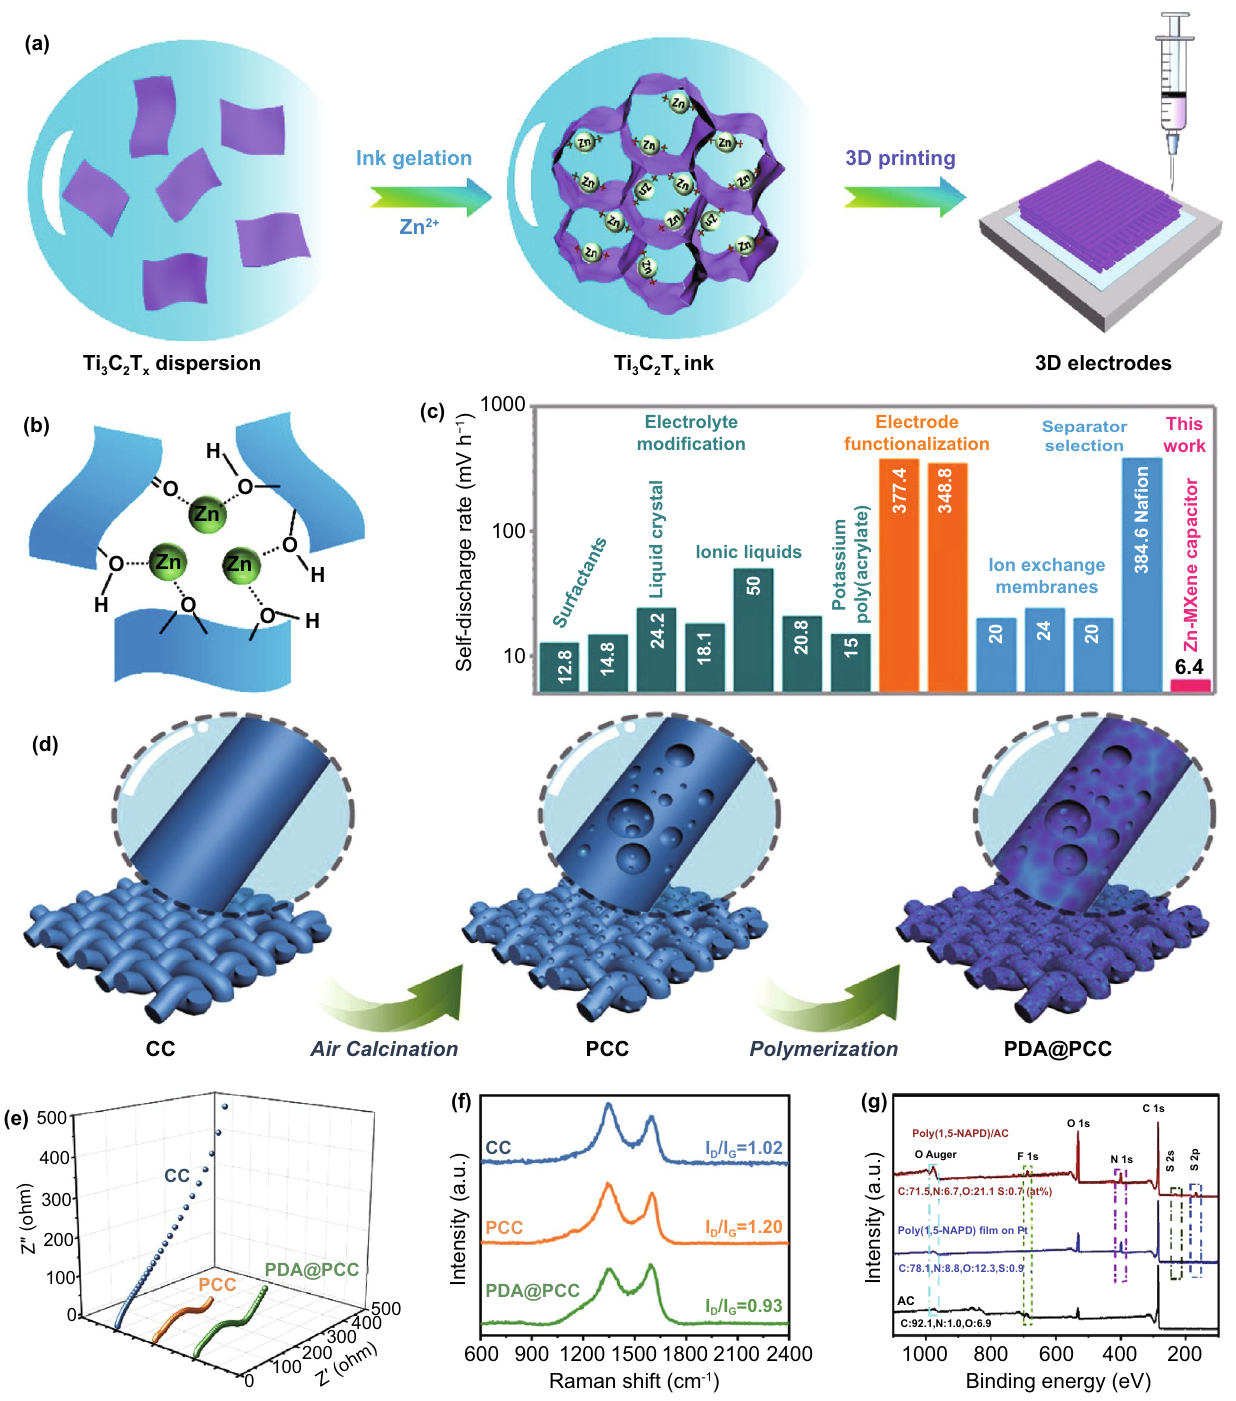
Fig. 6 a Illustration of MXenes ink formulation and the 3DP process. b Schematic illustration of the Zn‑ion gelation process targeting the preparation of MXenes ink. Reproduced with permission from Ref. [91]. Copyright 2021, American Chemical Society. c Comparison of self‑ discharge rate between the Zn//MXenes capacitor and previously reported anti‑discharge supercapacitors. Reproduced with permission from Ref. [96]. Copyright 2019, American Chemical Society. d Preparation process of the PDA@PCC electrode. e Nyquist plots and f Raman spectra of CC, PCC and PDA@PCC electrodes. Reproduced with permission from Ref. [154]. Copyright 2020, American Chemical Society. g XPS spectra of poly(1,5‑NAPD)/AC cathode, poly(1,5‑NAPD) film on Pt, and AC coating. Reproduced with permission from Ref. [77]. Copyright